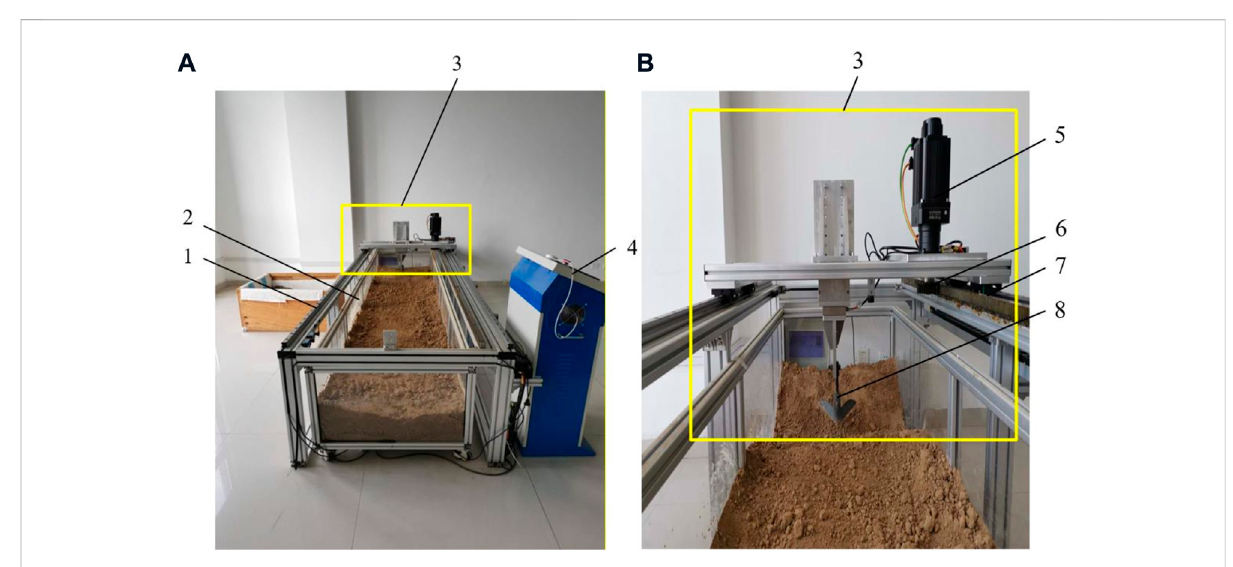
FIGURE 2 Soil-bin testbed: (A) (1) bogie guide rail, (2) soil bin, (3) bogie, (4) control cabinet; (B) (5) geared motor, (6) gearwheel, (7) rack, (8)